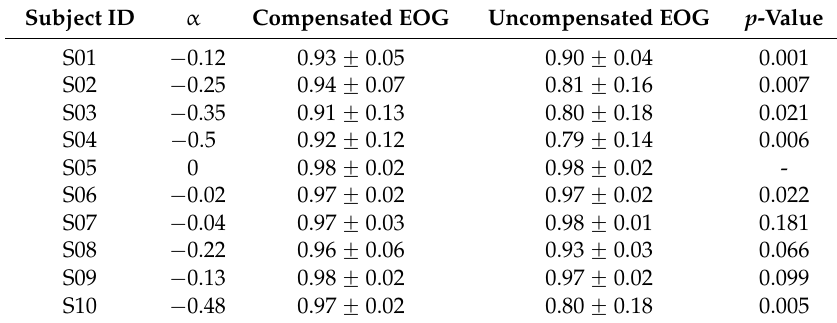
Table 2. Individual compensation constants and Pearson’s correlation coefficients. The p -values were calculated between the coefficients of the vertical components of the compensated and measured EOGs. The p value for Subject 5 was not calculated because the two EOGs were